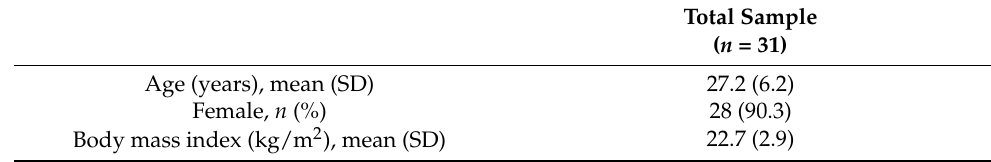
Figure 1. Consort diagram. Table 1. Demographic characteristics of